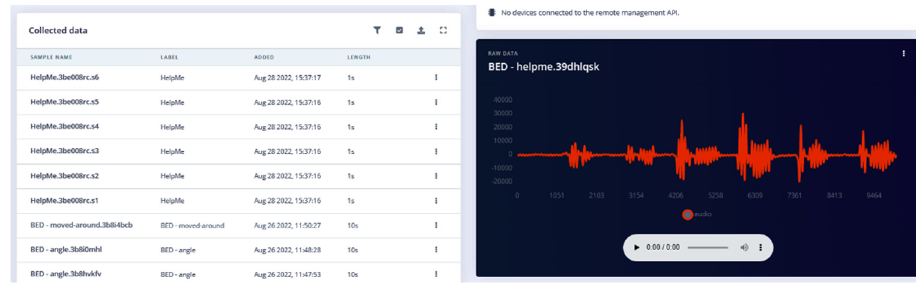
Figure 15. Collecting data for “Help Me!” “wake word”.